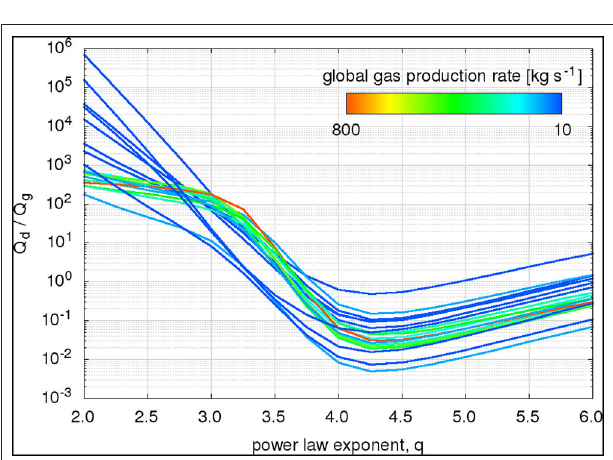
FIGURE 6 | The dust-to-gas mass production rate ratio, Q d / Q g as a function of the power-law exponent, q , is shown for each of the 18 OSIRIS images of this study. Each line represents an equal brightness curve where the respective q and Q d / Q g result in a synthetic image that matches the OSIRIS brightness. The colors of the curves indicate the global gas production rate of the respective